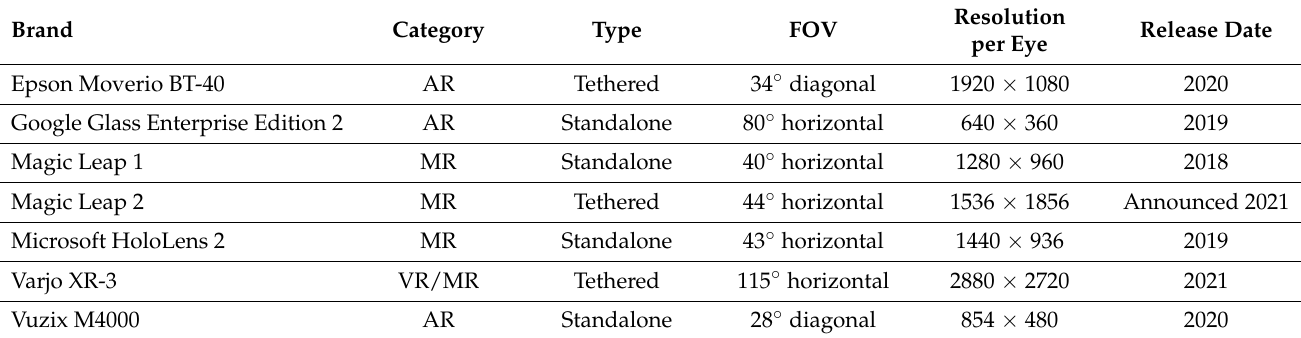
Table 8. Main AR and MR devices on the market.